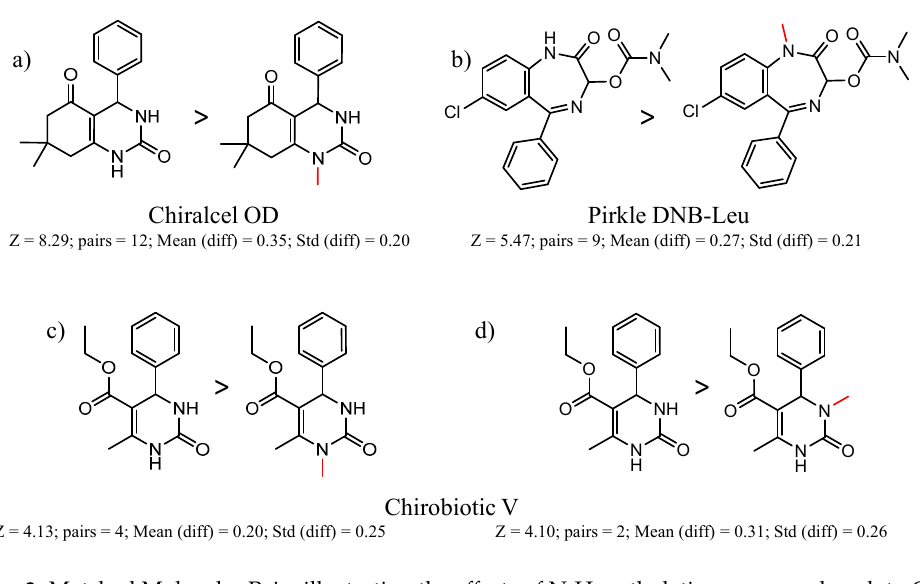
Figure 3. Matched Molecular Pairs illustrating the effects of N-H methylation on several analyte-CSP combinations.